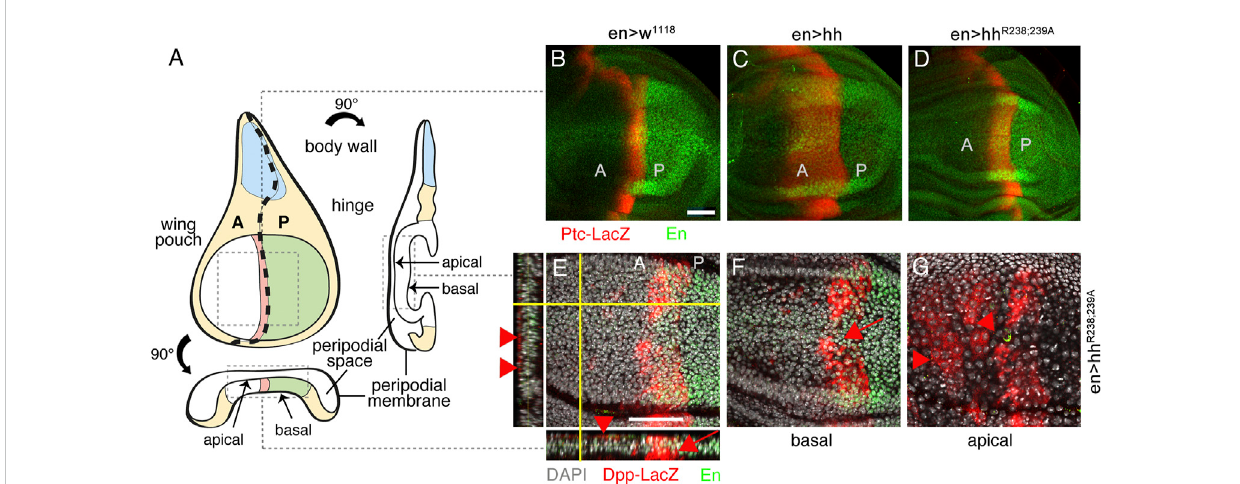
FIGURE 5 Different Hh variant activities in the developing wing disc. (A) An imaginal wing disc consists of an epithelial sheet of cells that form a sac-like infoldingoftheepithelium.Hhisproducedintheposteriorcompartmentofthewingdiscunderencontrol(labeledgreen)andmovesacrosstheanterior/ posterior (A/P) boundary into the anterior compartment to induce Ptc and Dpp expression at the A/P border (labeled red). Frontal, orthogonal and axial wing disc views are shown. (B – D) Ptc-LacZ target gene expression (labeled red) in en > w 1118 , en > hh and en > hh R238;239A wing discs. Note reduced relative Ptc-LacZ expansion in en > hh R238;239A wing discs if compared with discs that overexpress Hh. (E) Views of a merged Z-stack of a disc expressing Hh R238;239A . In addition to expected Dpp-LacZ expression in the disc proper (arrow), Dpp-LacZ was also expressed at ectopic anterior sites of the peripodial membrane (arrowheads). (F, G) Confocal imagesofbasal (F) andapical (G) layers takenfromthesameHh R238;239A expressingwingdisc con fi rm ectopic Dpp-LacZ expression at the peripodial membrane. Ectopic Dpp-LacZ expression in this tissue was never observed in Hh overexpressing discs (Supplementary Figure S5). Anti- β -Gal staining visualized Ptc-LacZ and Dpp-LacZ (red). Anti-en-antibodies indicate the Hh-producing (posterior) compartment (labeled green). Scale bars: 50 μ